Question: Author a descriptive caption for the visualization shown.
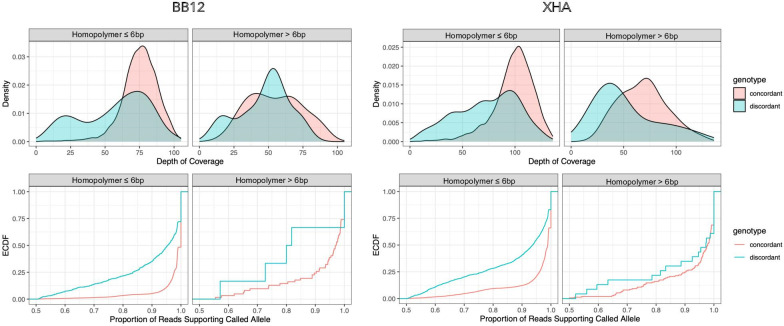
Answer: Variant quality metrics for discordant and concordant Nanopore genotype calls in both long homopolymeric (>6 bp) and short/non-homopolymeric (≤6 bp) regions for laboratory isolates: ( a ) BB12 and ( b ) XHA. Density plots show distributions for the depth of coverage by locus. Calls are labelled concordant or discordant based on agreement with Illumina genotypes at the same locus. Density plots show read depth distributions by locus. Empirical cumulative distribution functions (ECDFs) show distributions for the proportion of reads supporting the called allele. Left-shifted curves indicate lower support for detected alleles. In both homopolymeric and non-homopolymeric regions, discordant calls frequently had a smaller proportion of reads supporting the called allele than concordant calls.